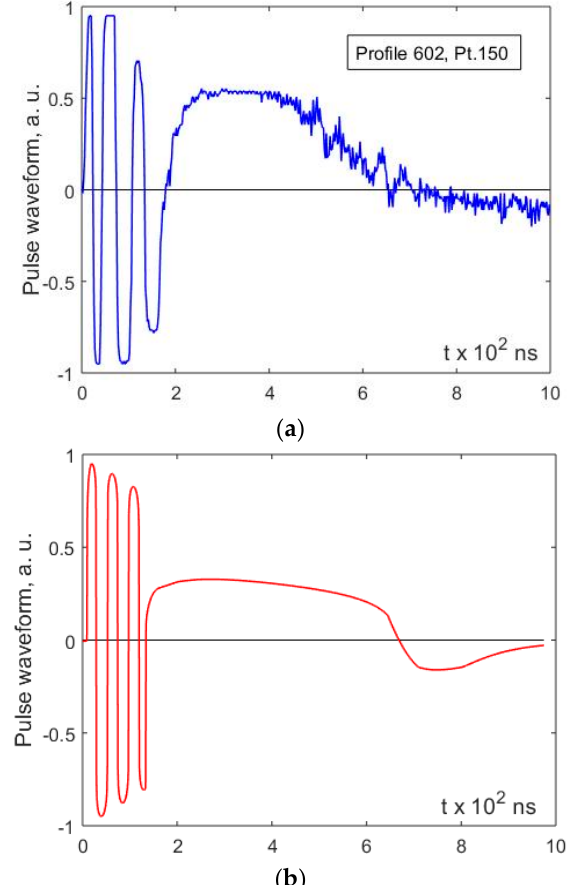
Figure 7. ( a ) Experimental A-scan with a protracted reflected pulse, recorded on the iced surface of Lake Chebarkul by GPR probing the silty bottom; and ( b ) synthetic A-scan calculated using our coupled-wave WKB approach.